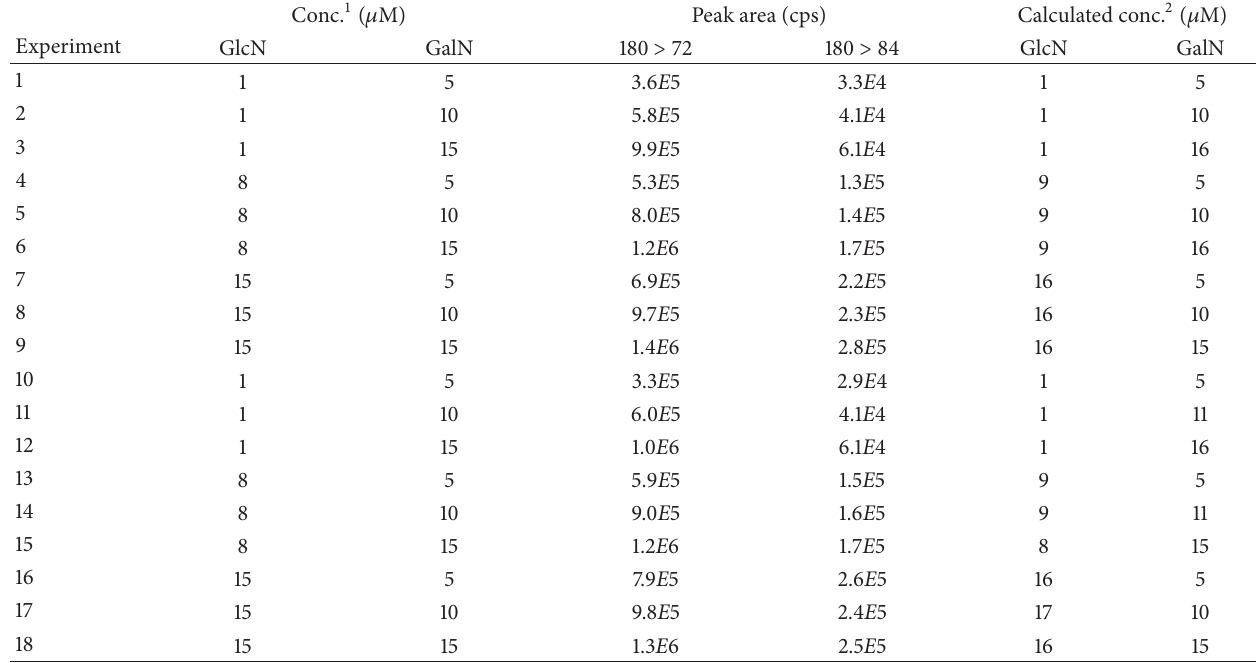
Table 1: In and output values of the full factorial design used to investigate the linear relationship of peak area for the 72 and 84 Th fragments in relation to known concentrations of glucosamine (GlcN) and galactosamine (GalN). Experiments were analyzed in random order. Conc. 1 ( 𝜇 M)